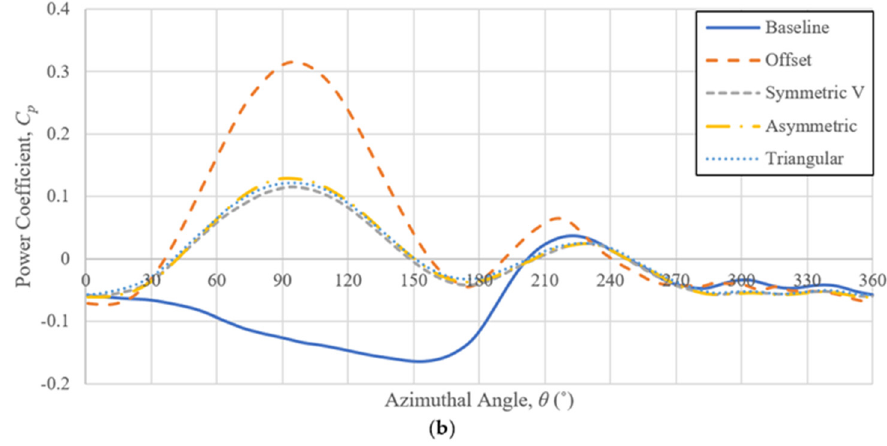
17 of 27 Table 4. Cycle-averaged C P at 0.015625H in TSRs 1 and 2. VAWT Configuration